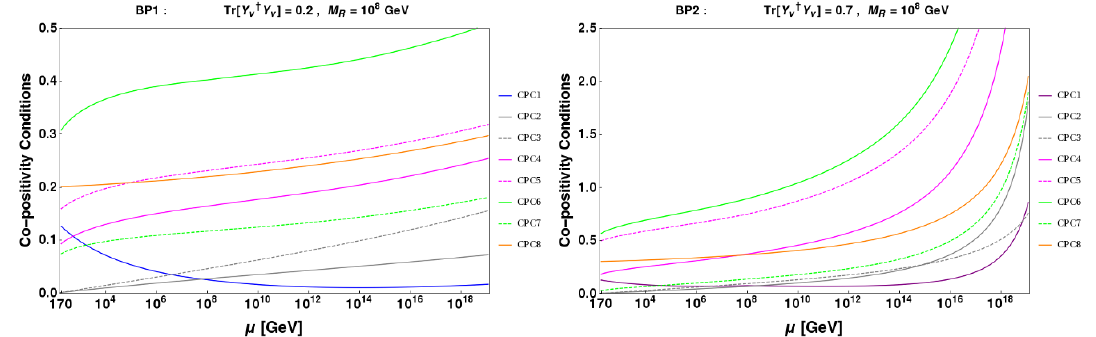
Figure 22 . RG running of all copositivity criteria in eq. (3.1) for BP1 (left) and BP2 (right) to ensure the boundedness of the scalar potential in any (cid:12)eld direction with energy scale (cid:22) for Tr[ Y y Y (cid:23) ] = 0 : 2 (left) and 0.7 (right) The choices of Tr[ Y y (cid:23) colours in left and right panels of (cid:12)gure 20 respectively to yield